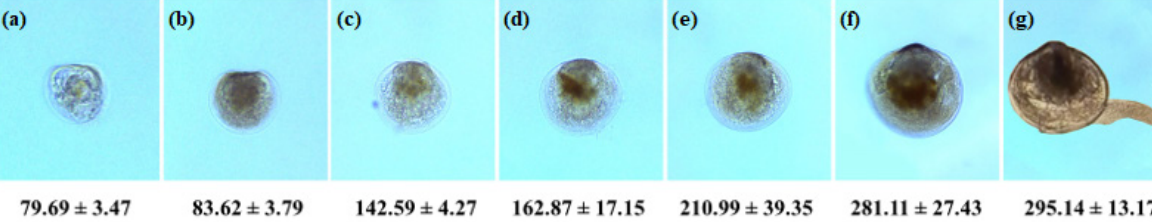
Figure 3. Larval development of Mesodesma mactroides. Mean (± SD) of shell length (μm) in the period of 27 days. (a) D-veliger, 1 st day; (b) D-veliger 2 nd day; (c) early umbonate larvae, 8 th day; (d) umbonate larvae, 10 th day; (e) umbonate larvae, 15 th day; (f) pediveliger, 25 th day; and (g) pediveliger, 27 th